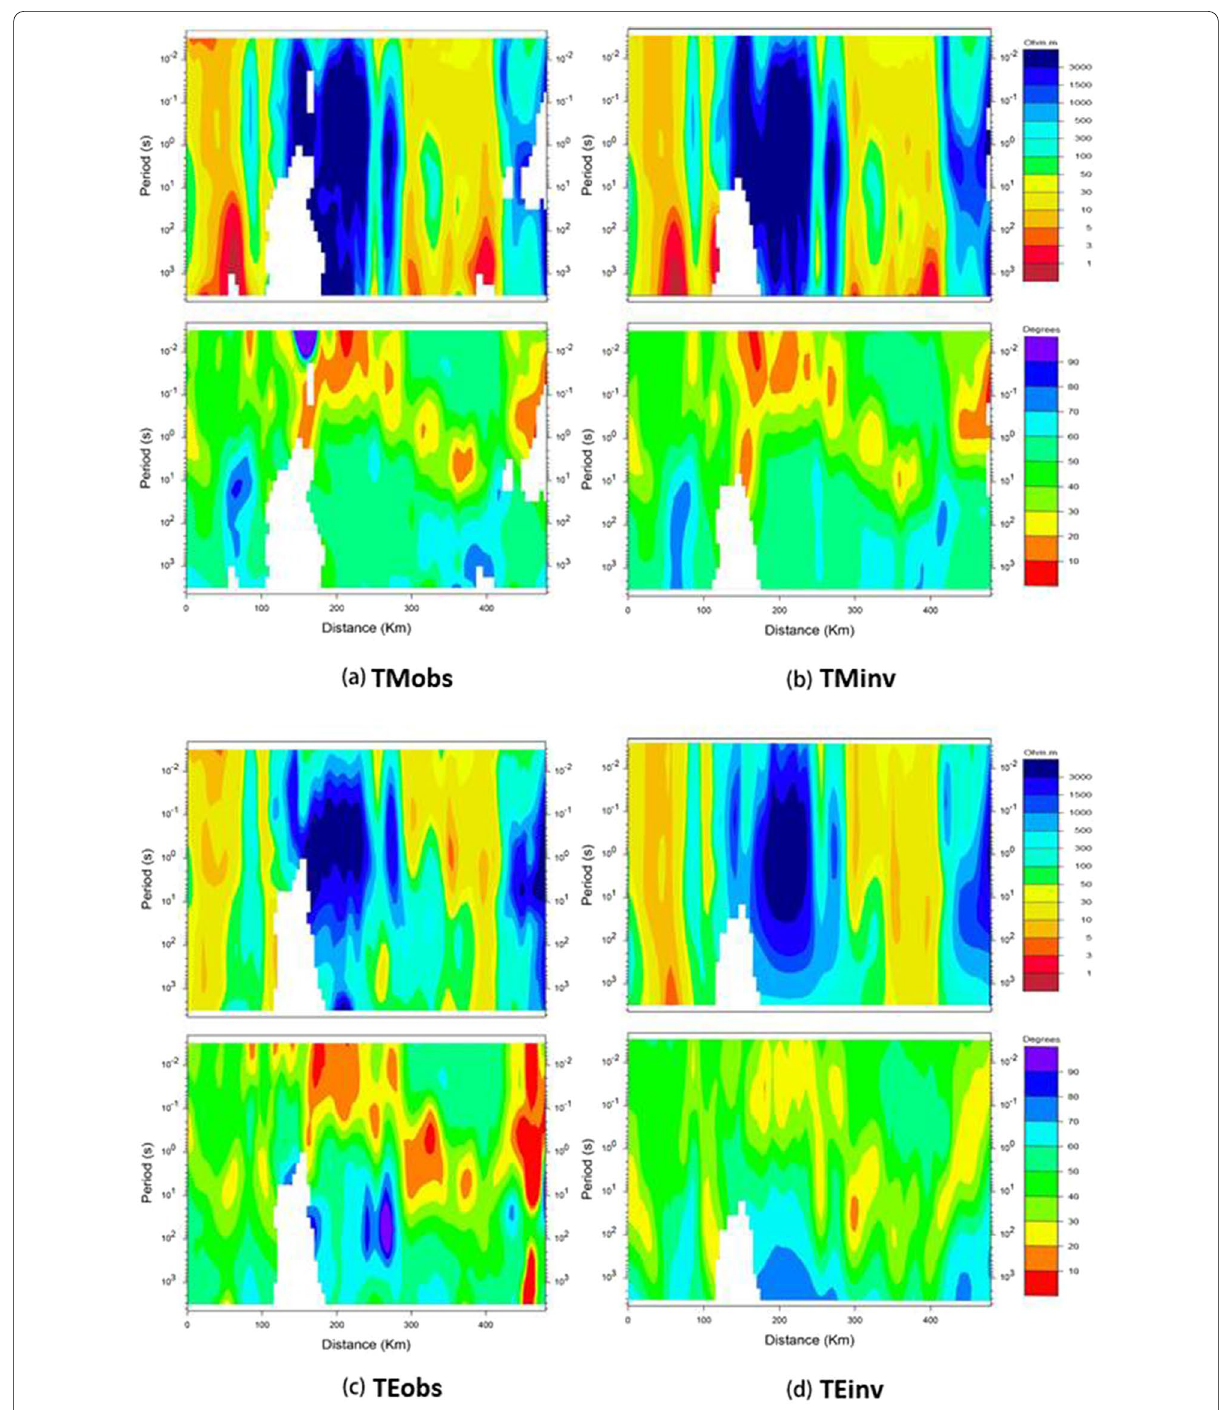
Fig. 8 Pseudo-sections of TM and TE modes. The left side represents the north. The subplots a – d are the pseudo-sections of measured data in TM mode, inversion response in TM mode, measured data in TE mode and inversion response in TE mode,